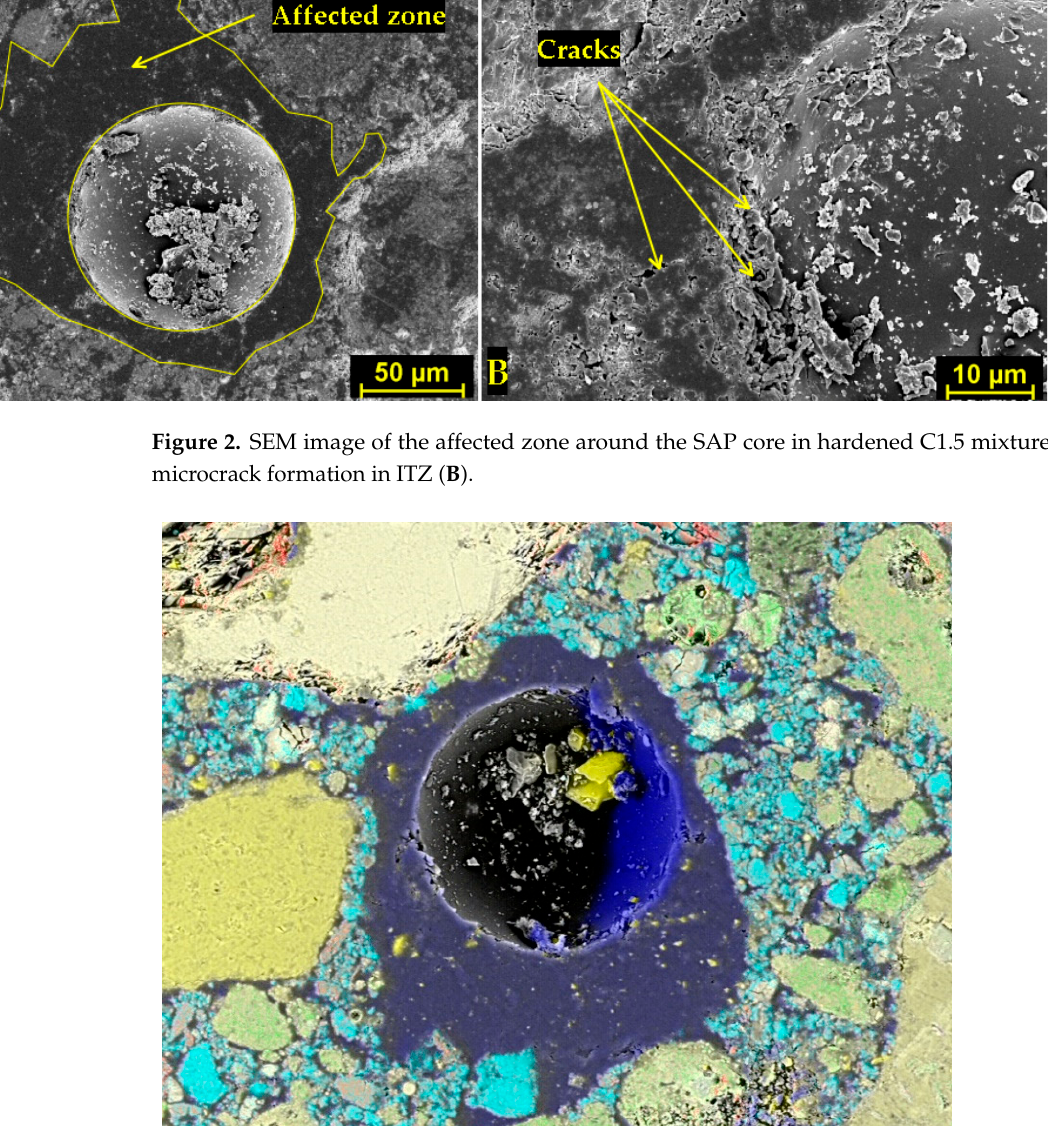
Figure 3. Element distribution map of hardened C1.5 mixture.